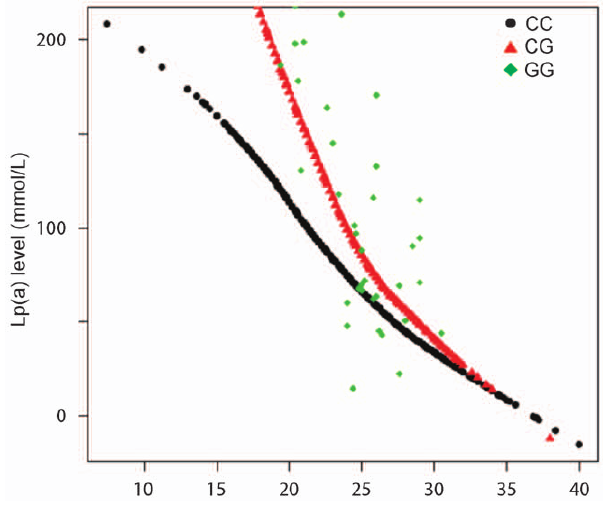
Figure 4. Variation of Serum Lp(a) with rs9457951 genotype in African Americans in DHS, stratified by kringle(IV) copy number. For genotypes CC and CG, the locally weighted scatterplot smoothing curve was drawn; for genotype GG, the raw data were plotted.